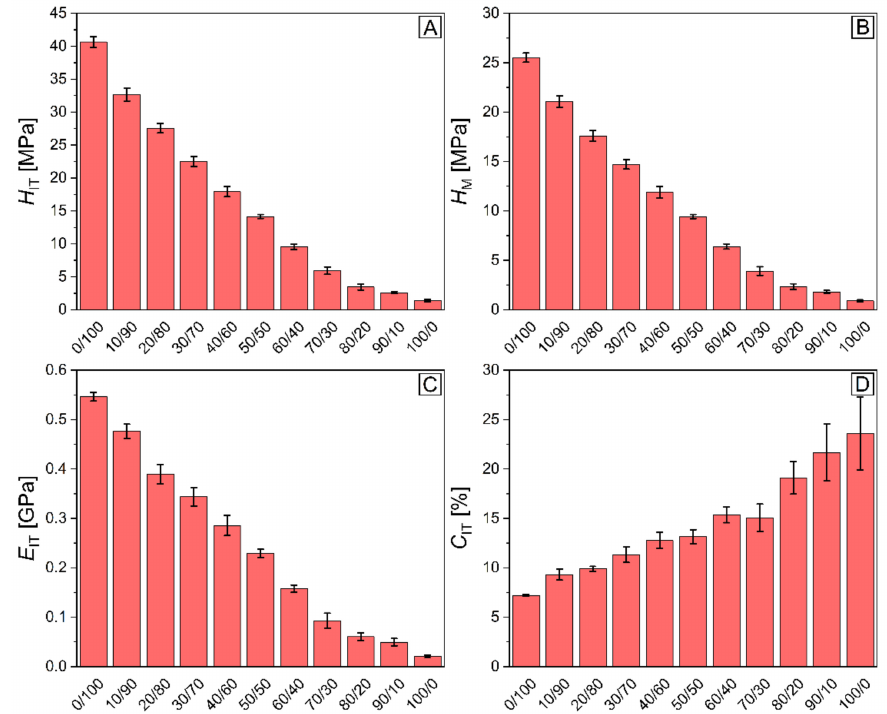
Figure A5. Selected micromechanical properties of the TPS and PCL and TPS/PCL blends in the form of bar charts with standard deviations: ( A ) indentation hardness, ( B ) Martens hardness, ( C ) indentation modulus and ( D ) indentation